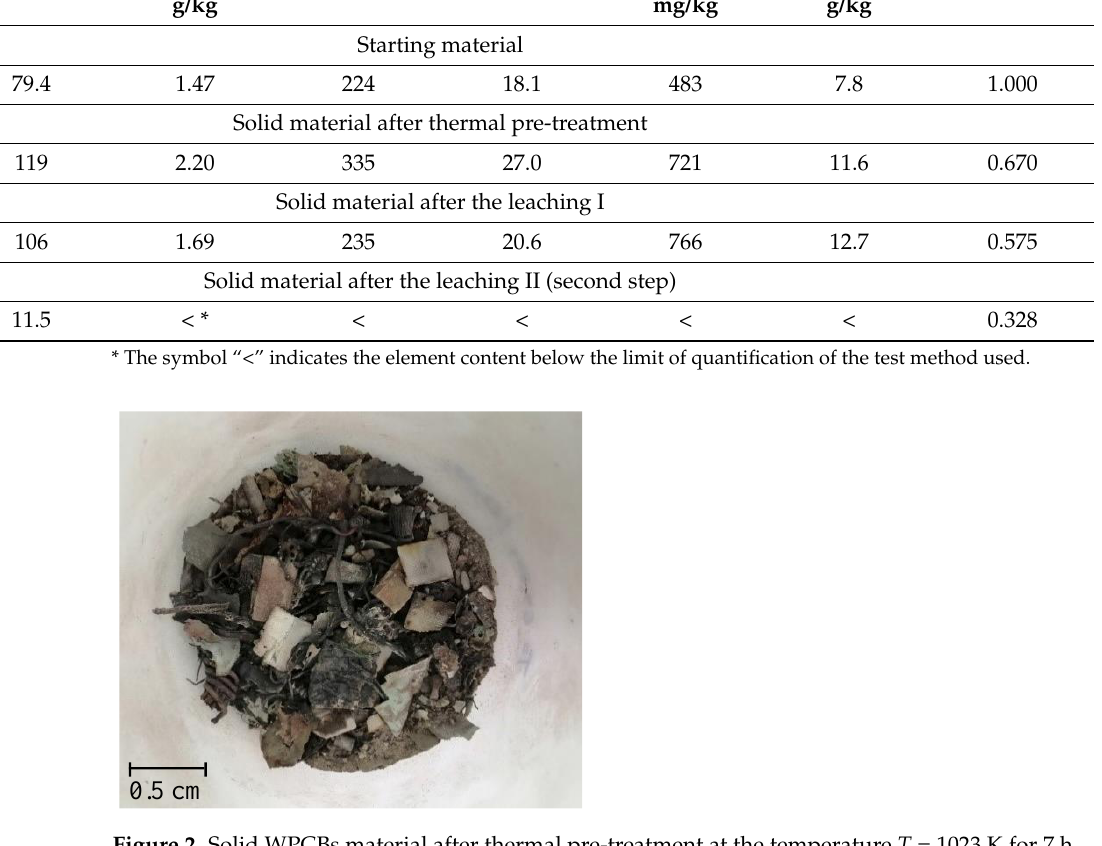
Figure 2. Solid WPCBs material after thermal pre-treatment at the temperature T = 1023 K for 7 h.